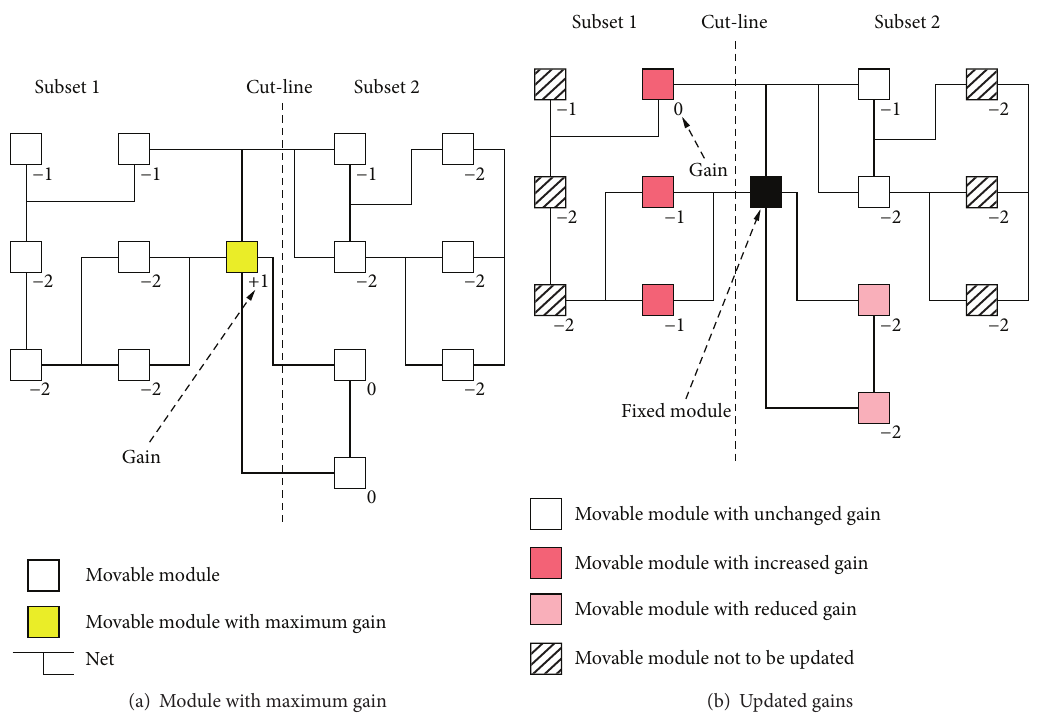
Figure 2: A movable module with the maximum gain is moved across the cut-line that separates the subsets and becomes fixed. The gains of other movable modules are then